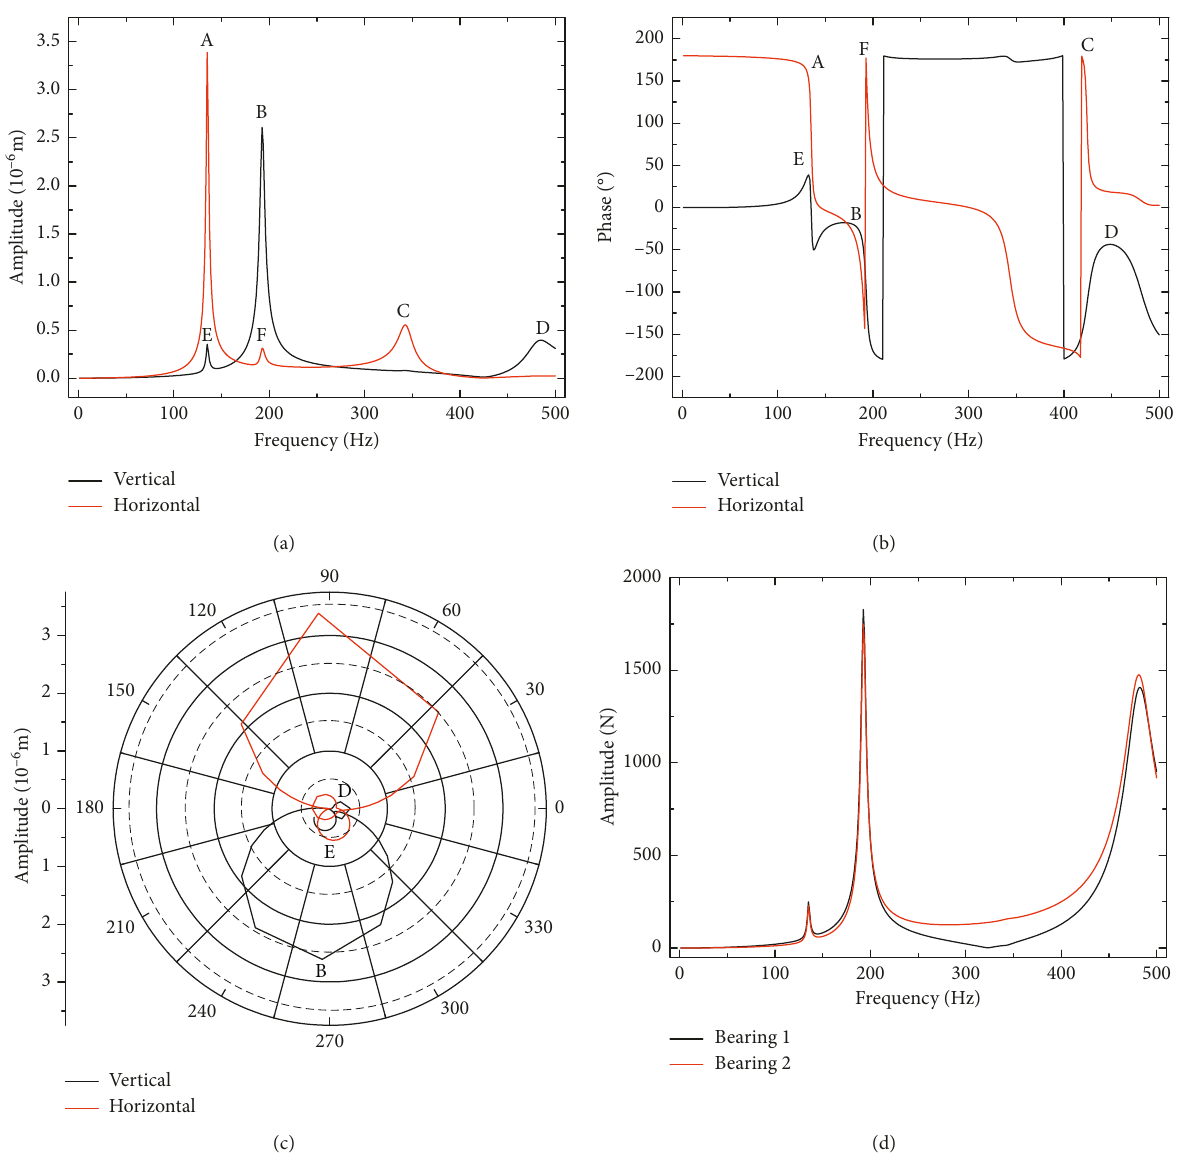
Figure 11: Rotor response and support reaction characteristics for condition 2 (anisotropic bearing stiffness). (a) Amplitude response at node 0. (b) Phase response at node 0. (c) Polar diagram at node 0. (d) Support reaction at vertical